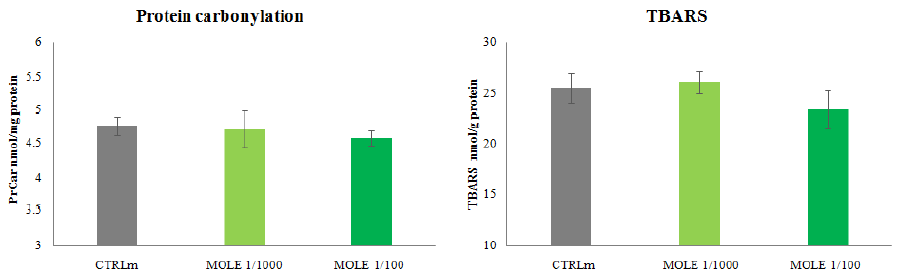
Figure 6. Thiobarbituric acid reactive substances (TBARS) and protein carbonyls (PrCar) analysis. Measurement of TBARS and PrCar analysis was performed in C2C12 myotubes after 24 h MOLE (1/1000 and 1/100 working solutions) treatments. Data presented are the mean ± SD of three experiments.